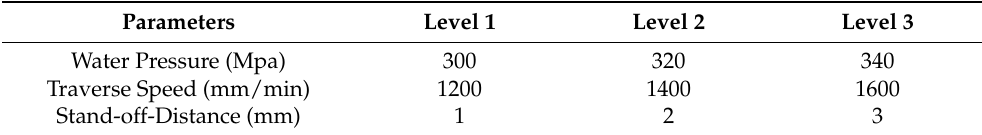
Table 6. Input parameters levels for specimen thickness of 6 mm, in the abrasive waterjet cutting